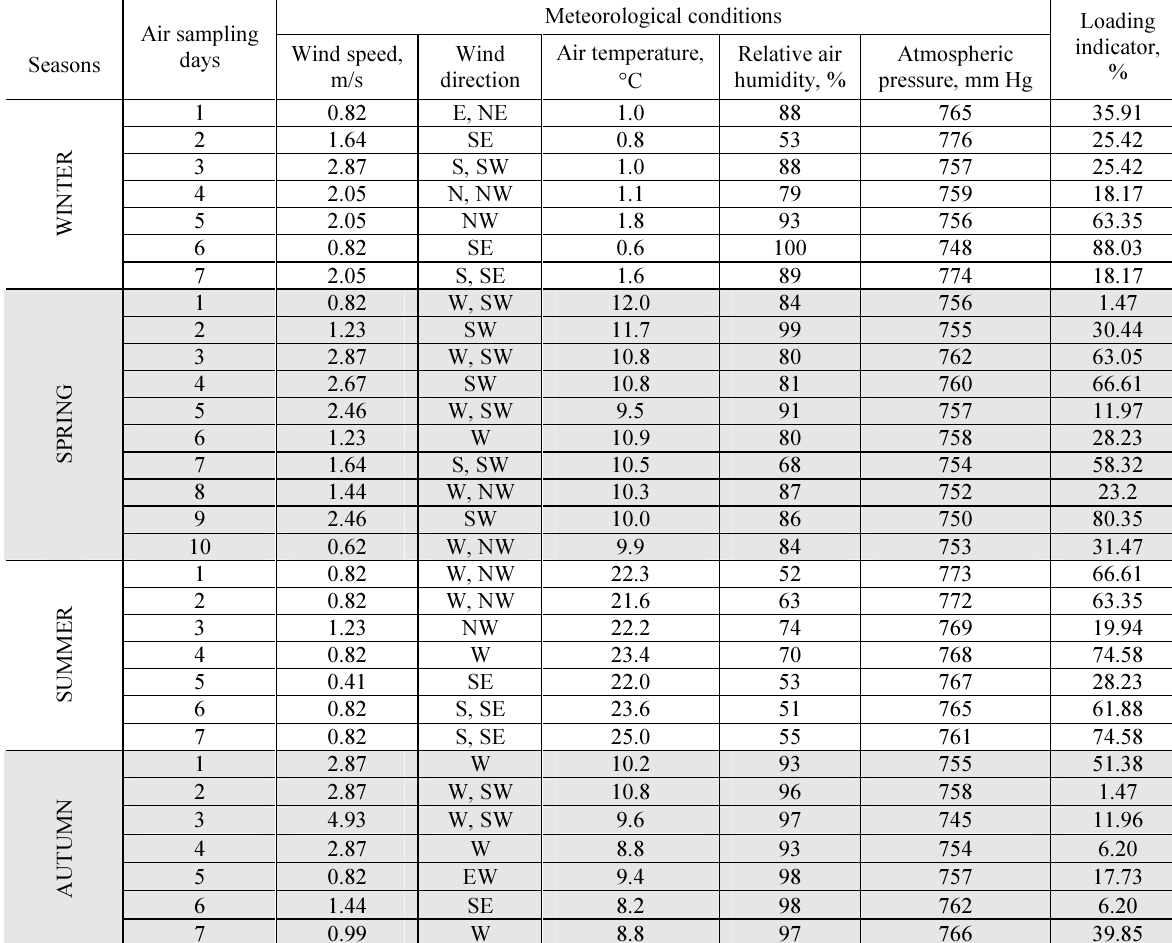
Table 3. Summary of meteorological conditions and loading indicator